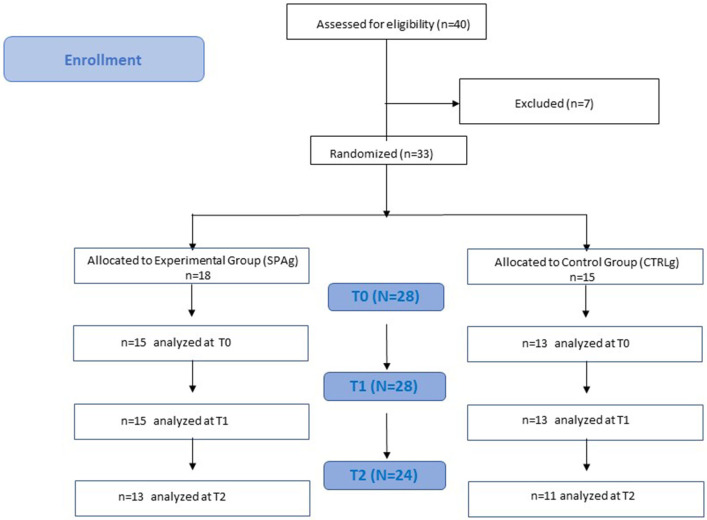
Flowchart study design. Clinical evaluation was performed at baseline (T0), after 4 weeks of treatment (T1), and 4 weeks after the end of treatment (T2). Both groups performed the training twice a week for 4 weeks in a rehabilitation pool of the Fondazione Santa Lucia (FSL) Hospital.